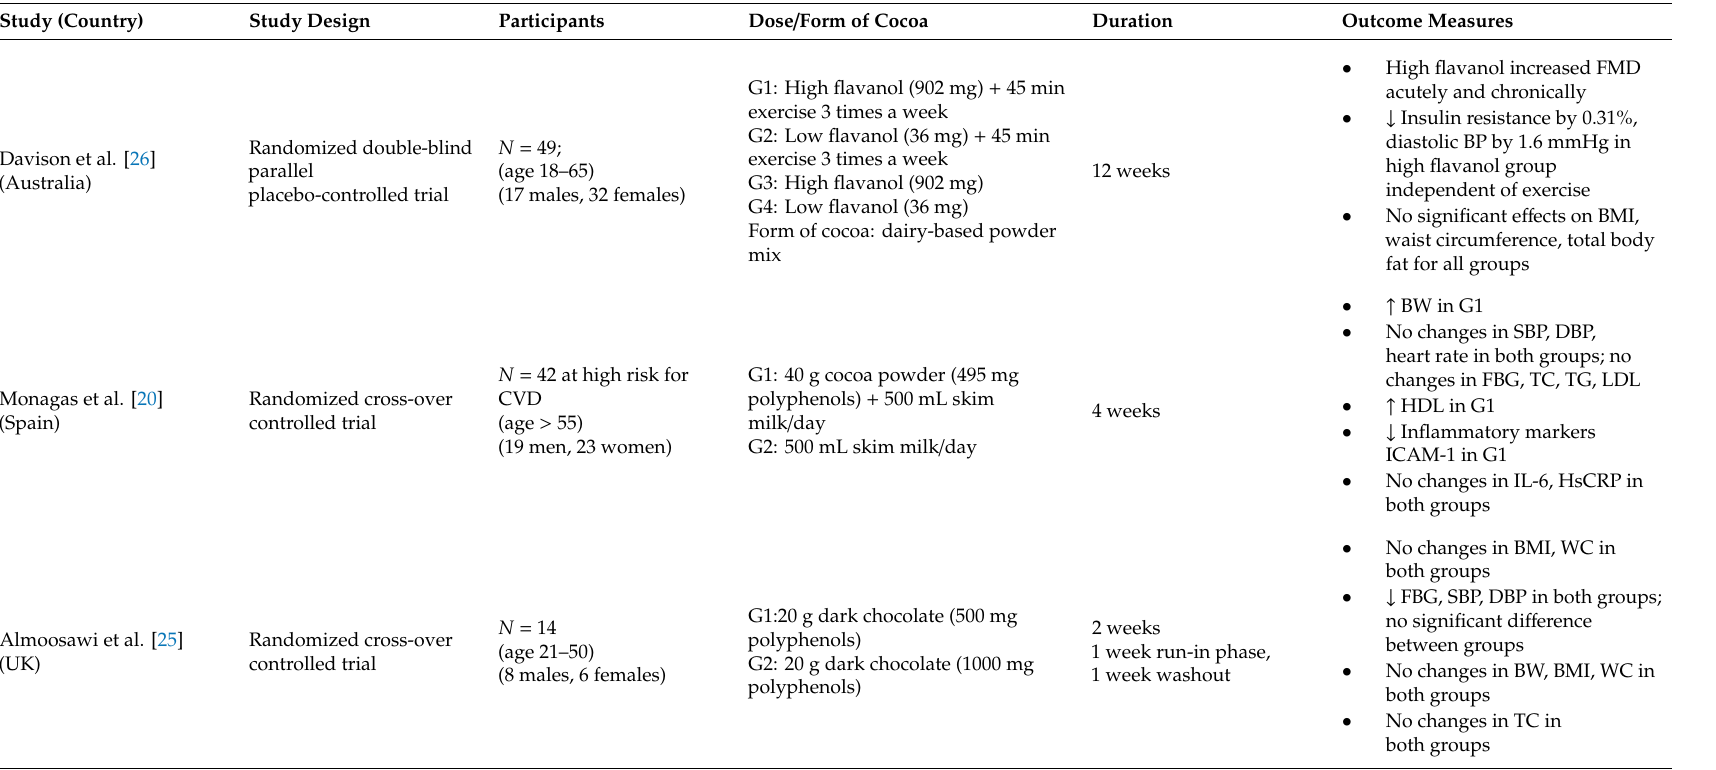
Table 2. Summary of studies assessing the e ff ects of cocoa / dark chocolate on obesity in